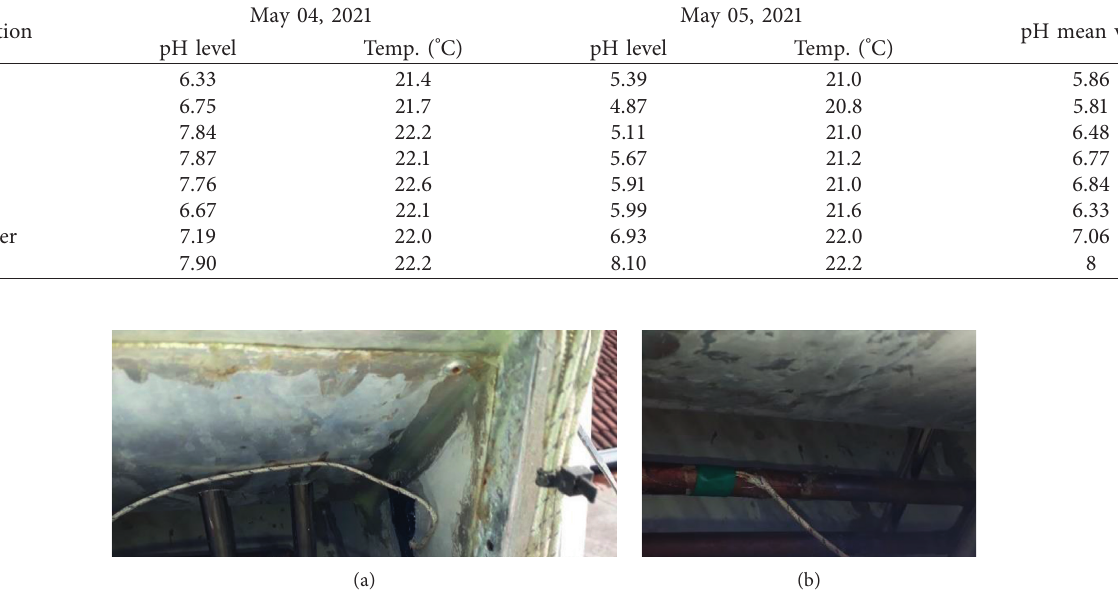
Figure 3: (a) Stage tray; (b) stage